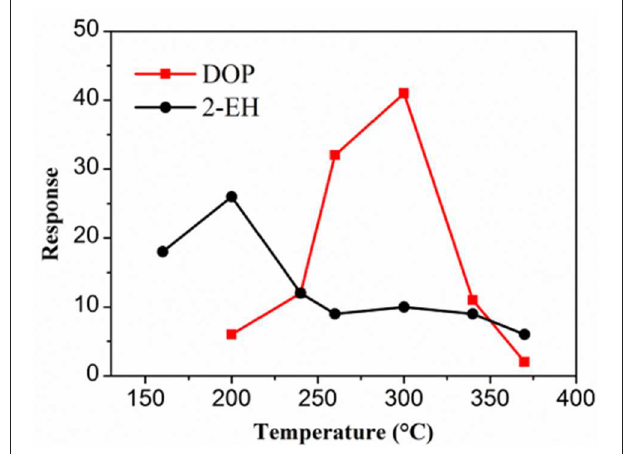
FIGURE 5 | Response variation of TGS-822 sensor with (A,B) the sampling volume and (C,D) temperature for vapors of (A,C) cable 1 and (B,D) cable 4. For comparison, data for simulated vapors consisting of only DOP and 2-EH standards are also presented.